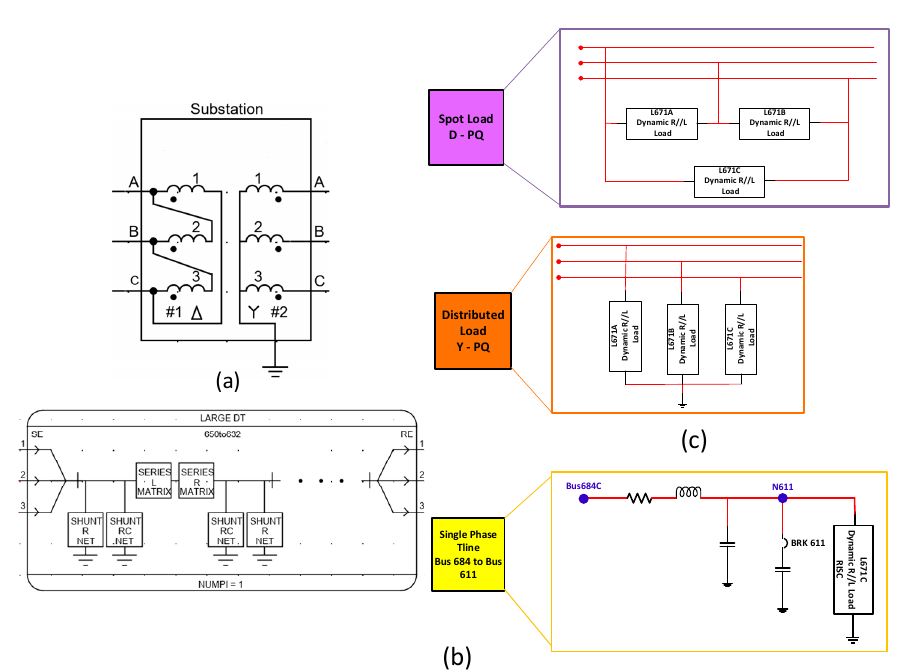
Figure 4. Modeling components used for constructing the distribution system in the real-time simulation testbed: ( a ) two-winding, three-phase transformer model; ( b ) PI section model for distribution lines; ( c ) hierarchy component boxes for loads.